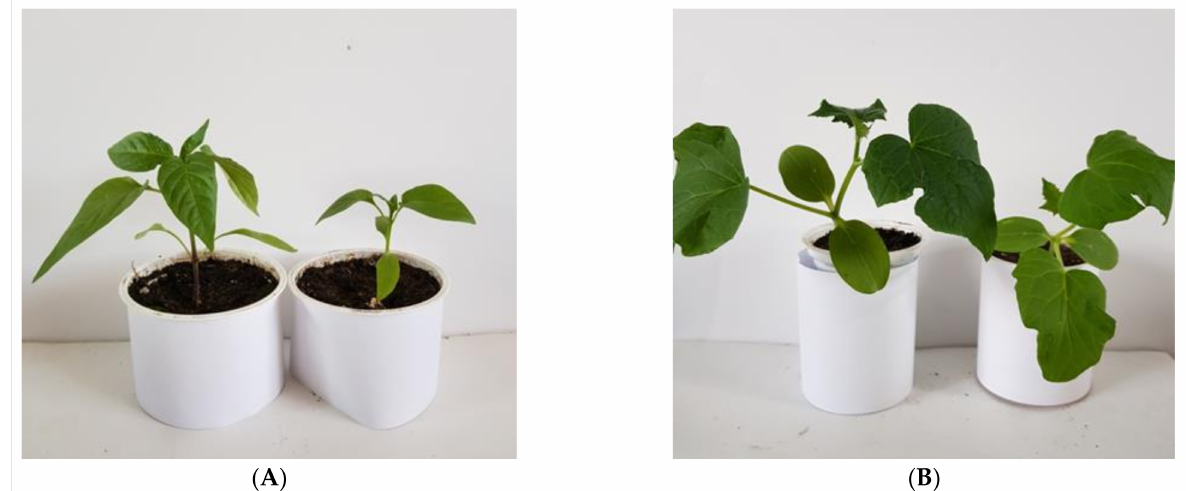
Figure 11. Effect of photoconversion polymer film on plant leaf size. Representative photographs of plants grown under AP-ZnO photoconversion material ( left in pair ) and acrylic polymer ( right in pair ). ( A ) Cucumber ( Cucumis sativus ). ( B ) Chili pepper ( Capsicum annuum